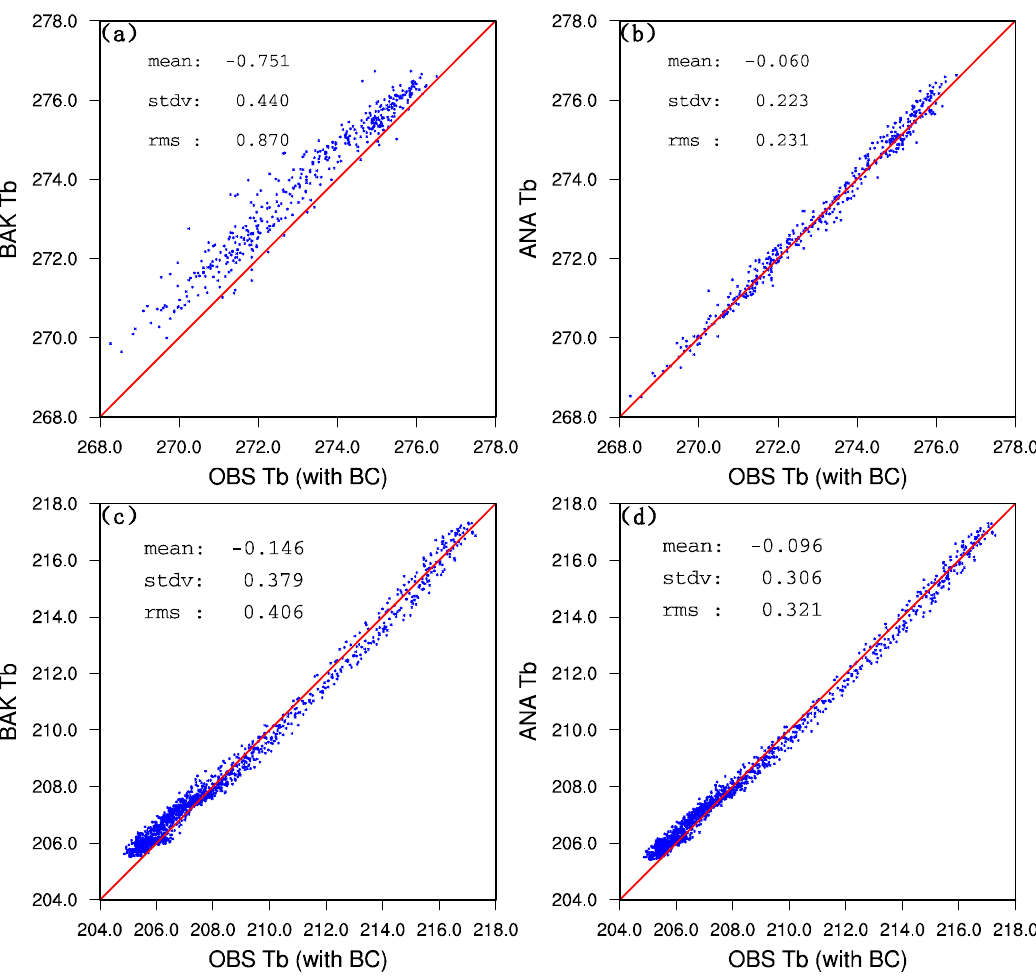
Figure 5. The observed brightness temperature (unit: K) and the simulated brightness temperature (unit: K) with the background and analysis of AIRS ( a ) before assimilation, ( b ) after assimilation with bias correction and of NOAA 15 AMSU-A ( c ) before assimilation, and ( d ) after assimilation with bias correction.